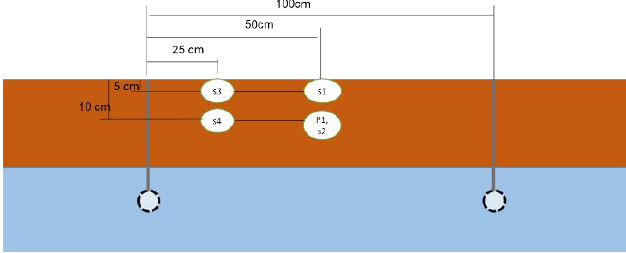
Fig. 4 Soil moisture observation, s: soil moisture, P: